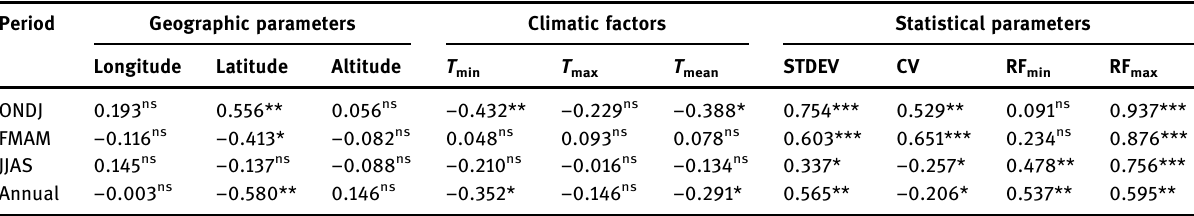
Table 1: Correlation ( R ) between the predictor variables before applying PCA